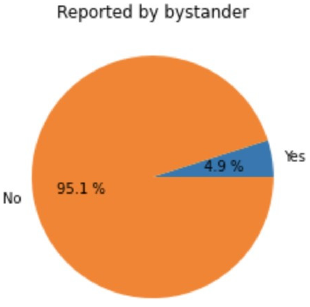
Figure 7. Volume of harassments reported by